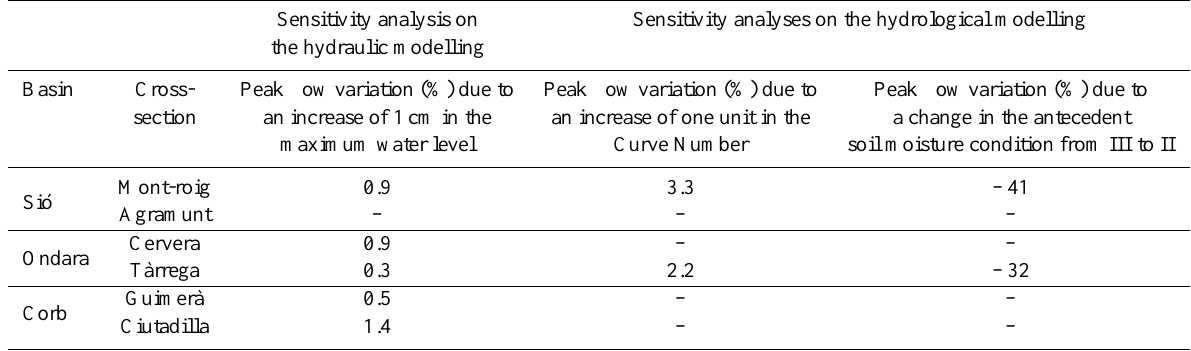
Table 4. Results of the sensitivity analyses on the hydraulic and the hydrological modelling. Sensitivity analysis